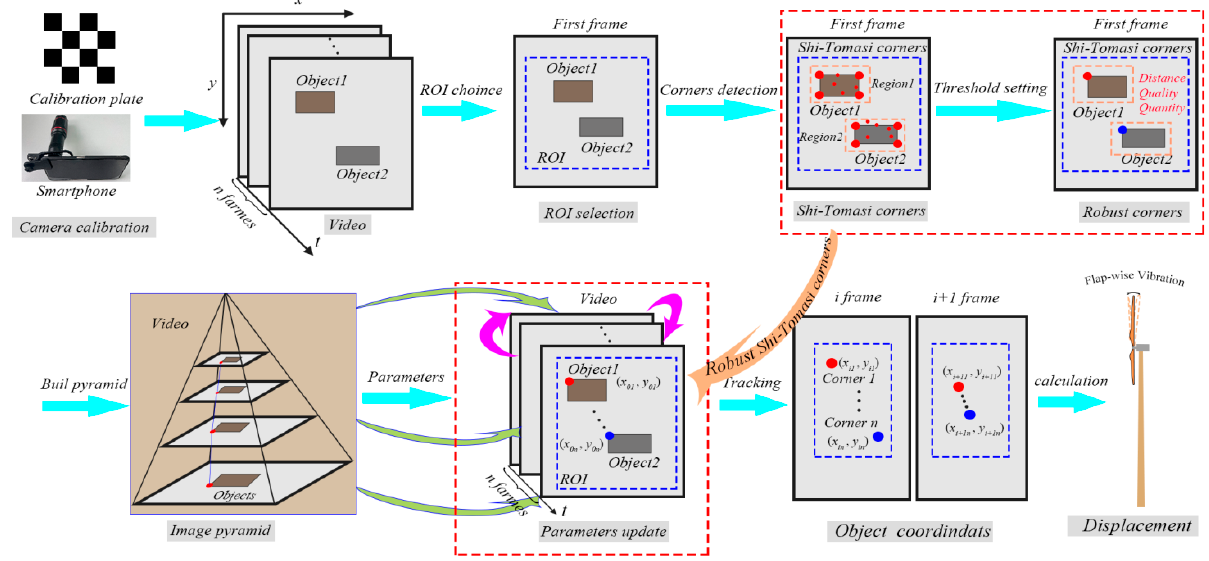
Figure 2. Target tracking based on ROI for target-free robust corner feature